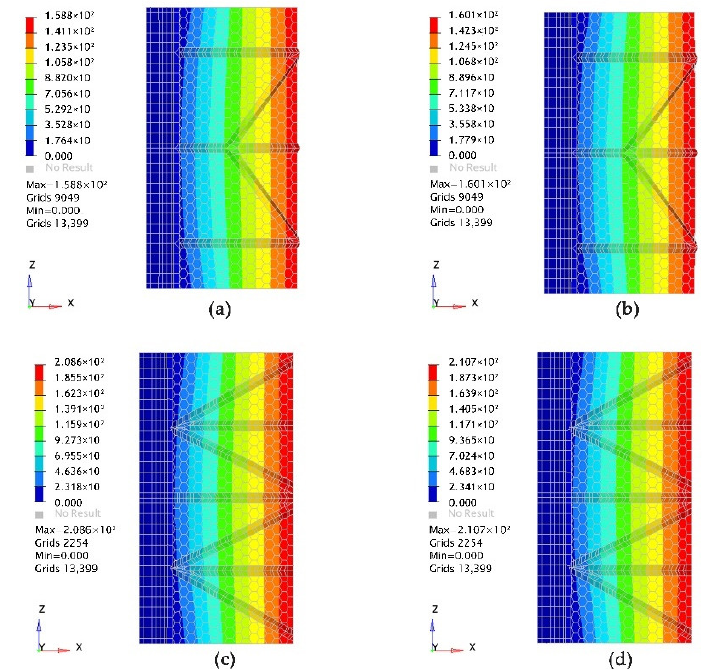
Figure 24. ( a ) Linear combined displacement analysis of carport I model under the G K load; ( b ) Nonlinear combined displacement analysis of carport I model under the G K load; ( c ) Linear combined displacement analysis of carport II model under the G K load; ( d ) Nonlinear combined displacement analysis of carport II model under the G K load.